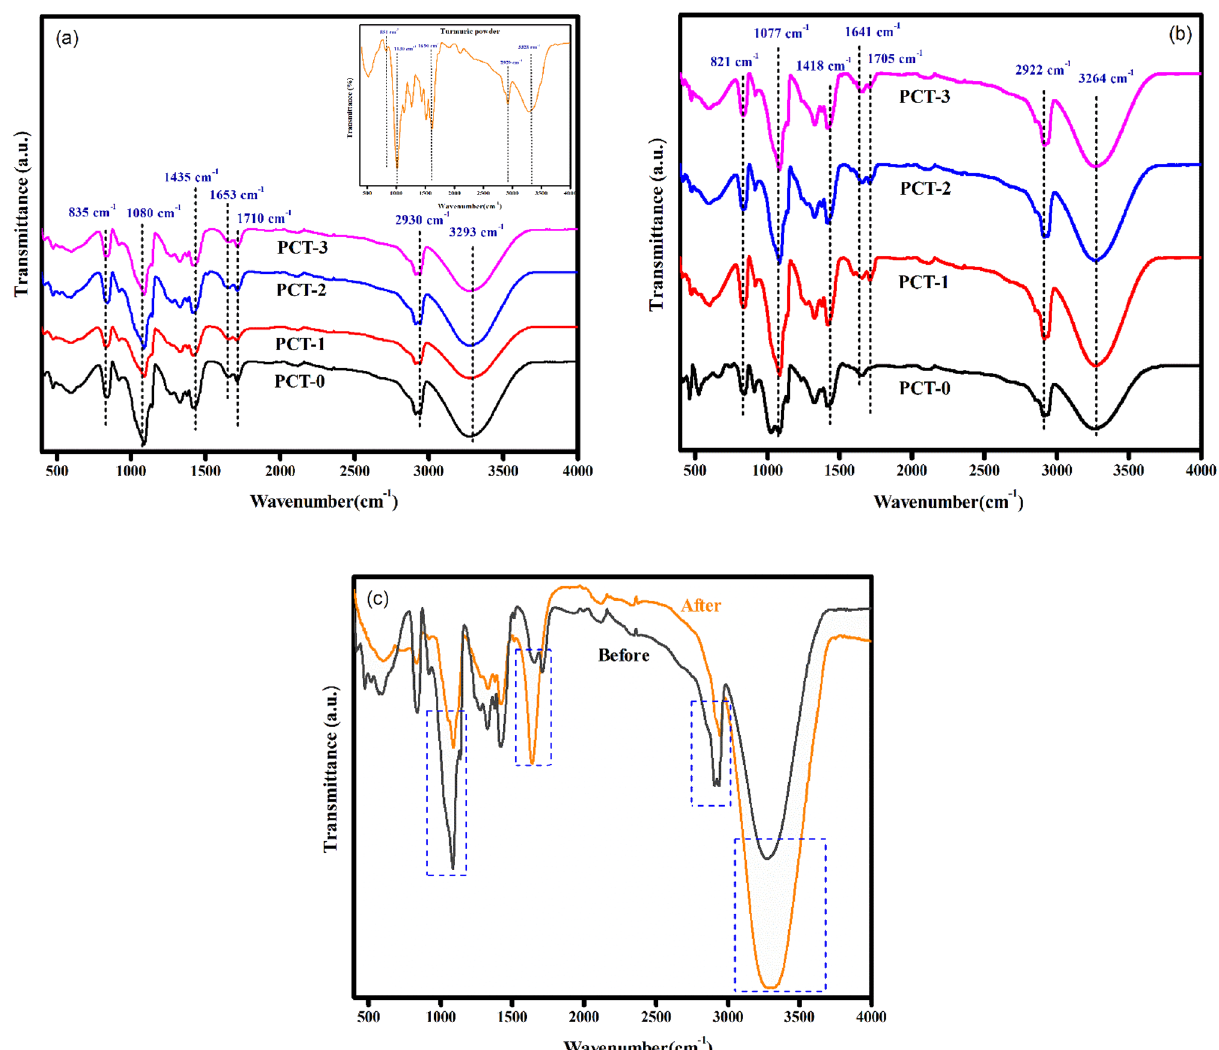
Figure 3. FTIR spectra of: ( a ) PVA/CMC with different percentage of turmeric (inset: turmeric powder) ( b ) MB dye on PVA/CMC/TUR film ( c ) Enhancement of peak intensity after MB adsorption on PVA/CMC/TUR films.